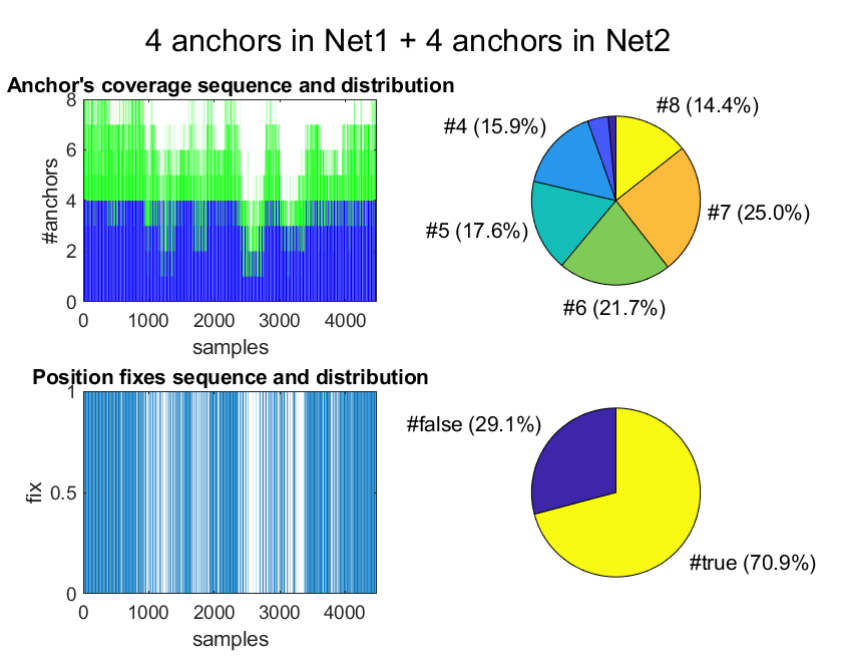
Figure 18. Coverage of anchors for one of the testing routes at the apartment. Top: Total number of anchors in view when considering the contribution of both tags in a pair (tag1&tag2). Bottom: Position fixes computed by the Decawave algorithm based on four anchors at a